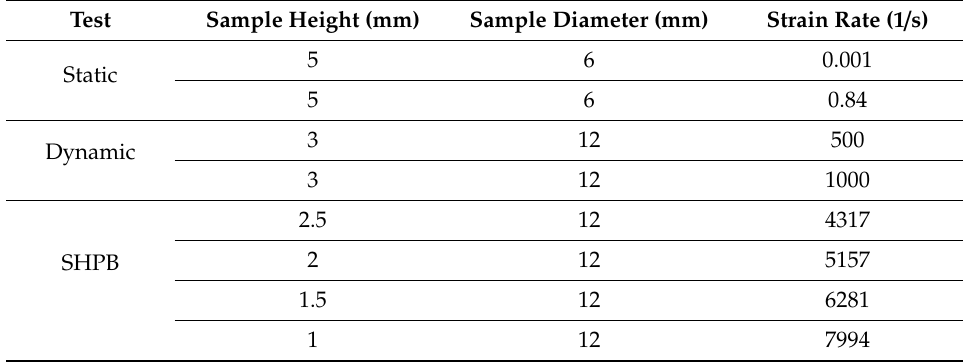
Table 1. Samples dimensions and achieved strain rates.